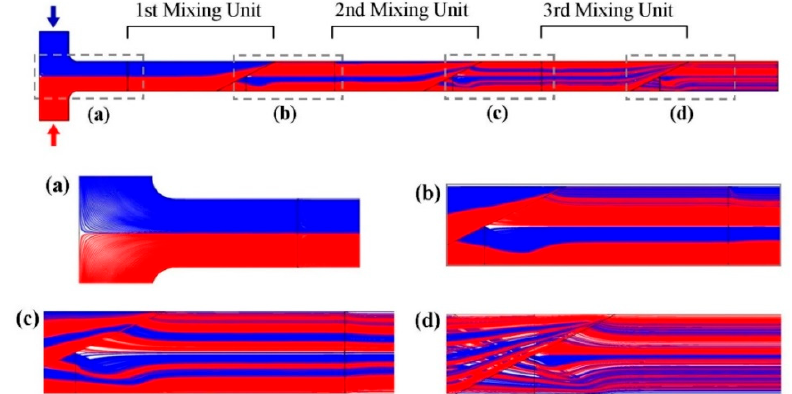
Figure 4. Generation of sub-streams represented by flow streamlines starting from inlets (blue and red). Streamlines are calculated with regard to velocity vectors obtained from the fluid flow simulation. Total number of 500 streamlines with a uniform density of starting position is plotted for each inlet. Due to the novel geometry of the mixing units, streamlines mix together as magnified views are illustrated for: ( a ) T-shaped inlet, ( b ) after passing through first mixing unit, ( c ) second mixing unit and ( d ) third mixing unit.